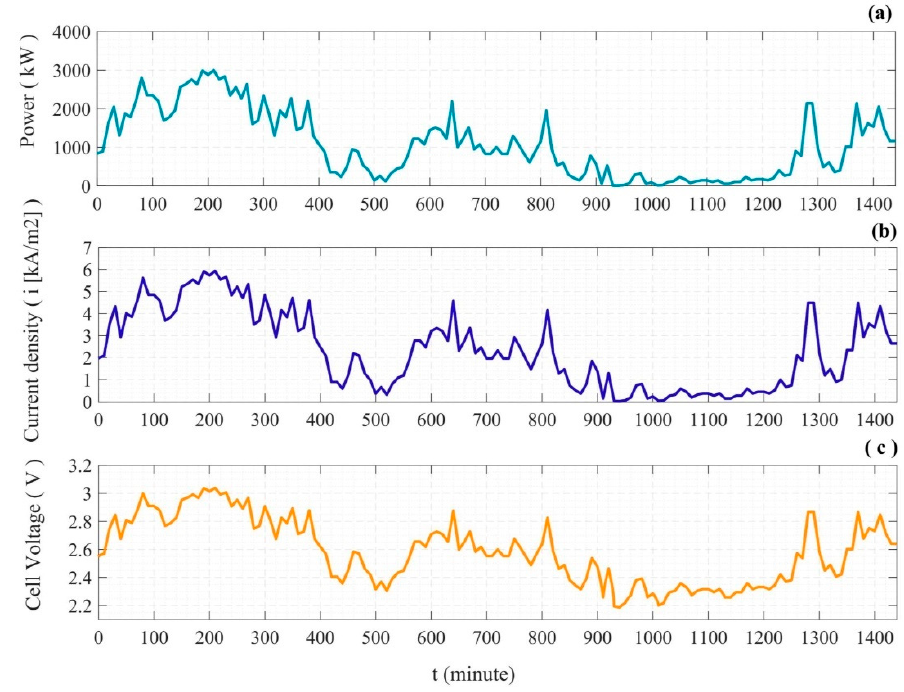
Figure 10. ( a ) Simulated wind power output profile, ( b ) resultant current density profile and ( c ) the associated transient response of the cell voltage over the course of a day. Operating conditions: temperature: T in an = T in cat = 85 ◦ C; and electrolyte concentration: X in = 300 gL − 1 .